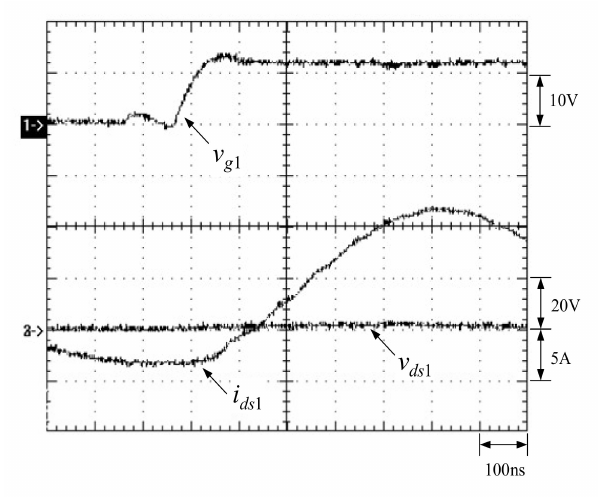
Figure 13. Zoom-in of Figure 12 for ZVS turn-on of S 1